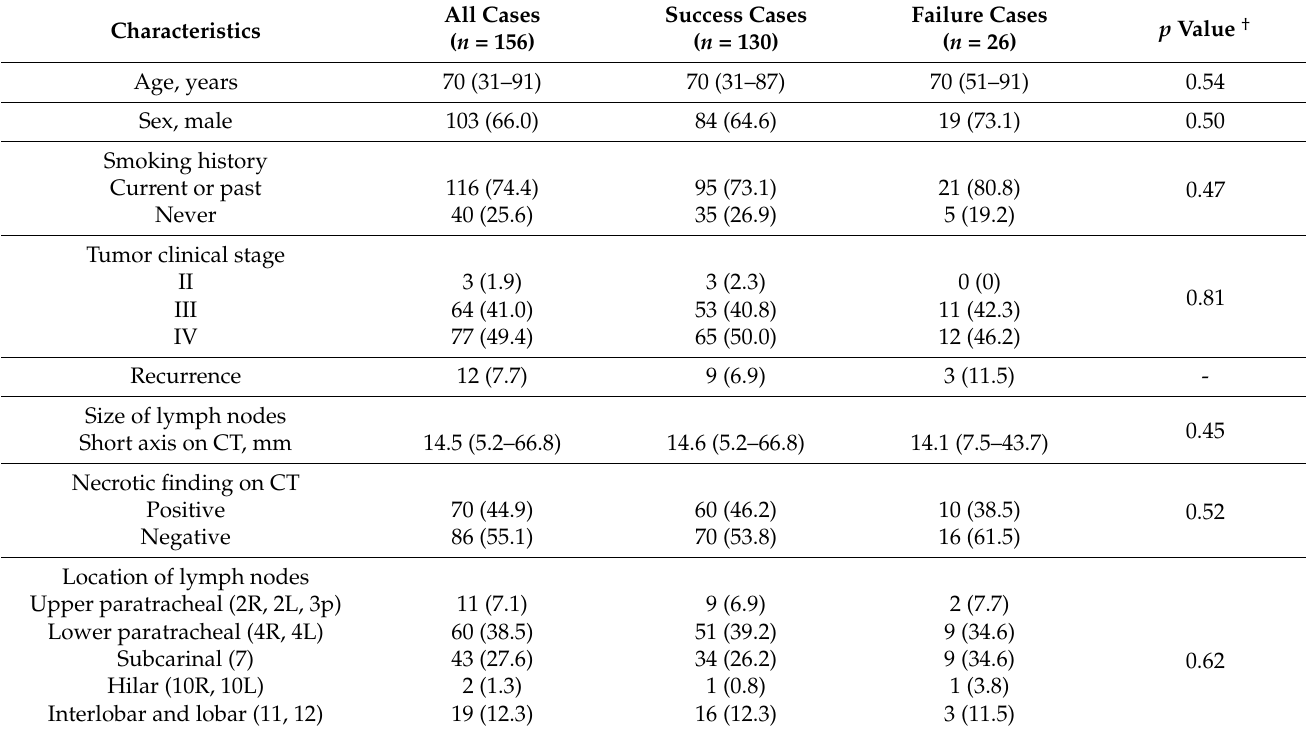
Table 2. Baseline characteristics of patients who underwent next-generation sequencing using specimens obtained through endobronchial ultrasound-guided transbronchial needle aspiration.